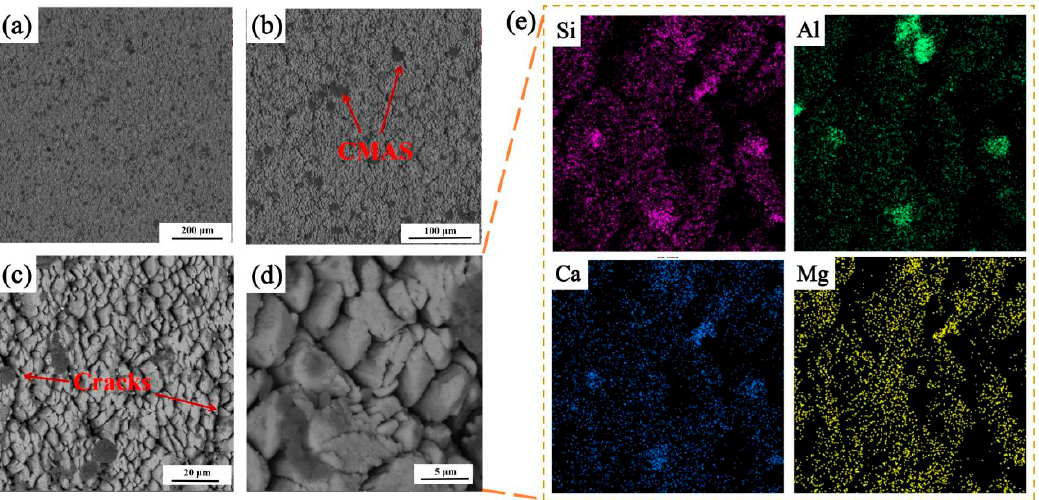
Figure 7. SEM images of the surface of the 8YSZ coating after failure: ( a – d ) micro-morphology of the coating surface of sample 1 under different magnifications; ( e ) EDS mapping of the image ( d ). Cross-sectional SEM images of the TBC specimen after failure are shown in Figure